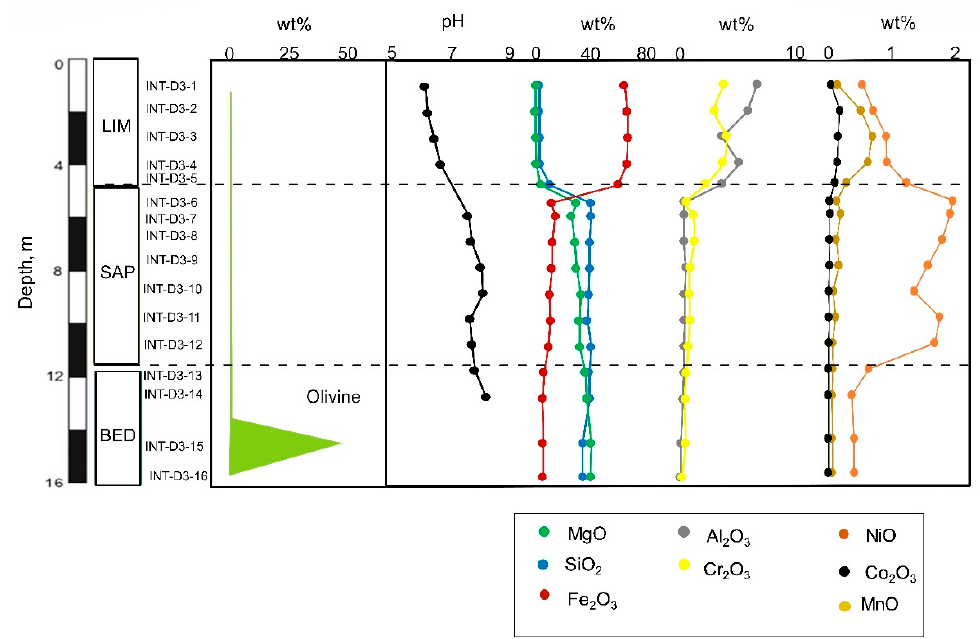
Figure 17. Distribution of olivine, pH and elements with depth in the laterite derived from harzburgite-dunite bedrock (BB2406 core).